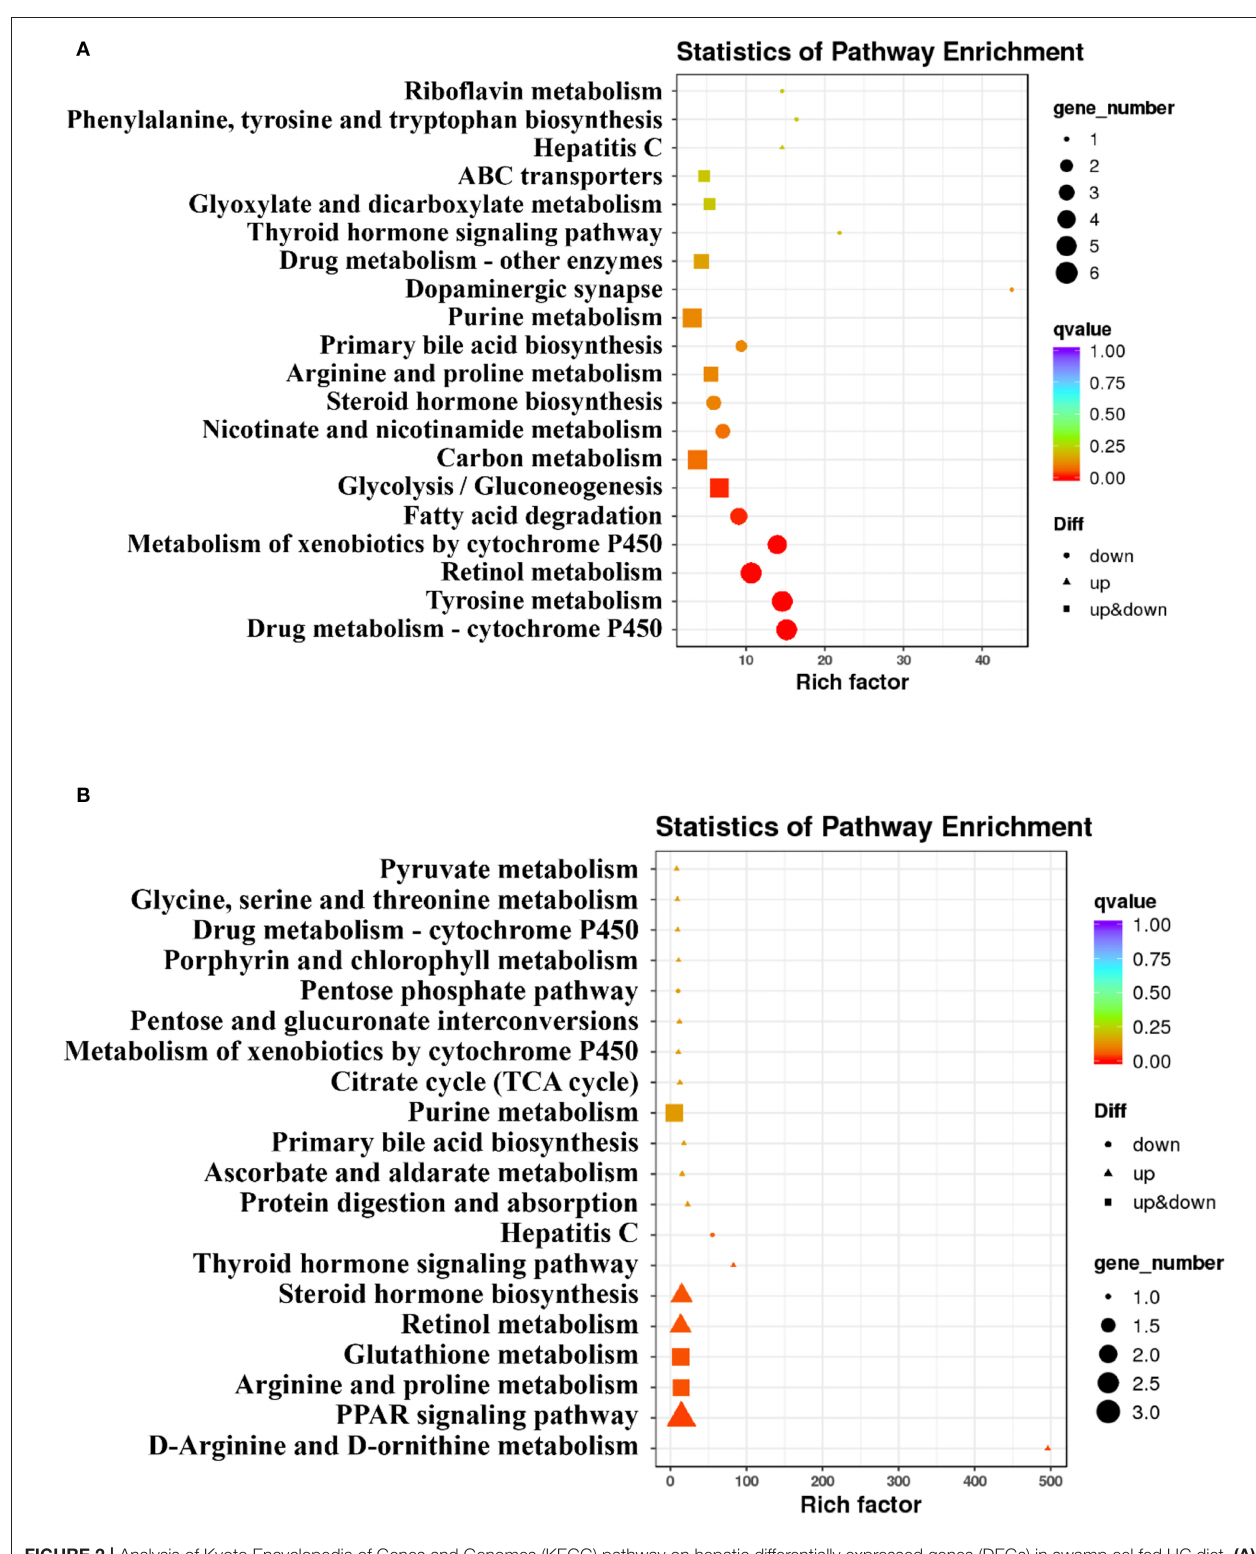
Frontiers in Veterinary Science |